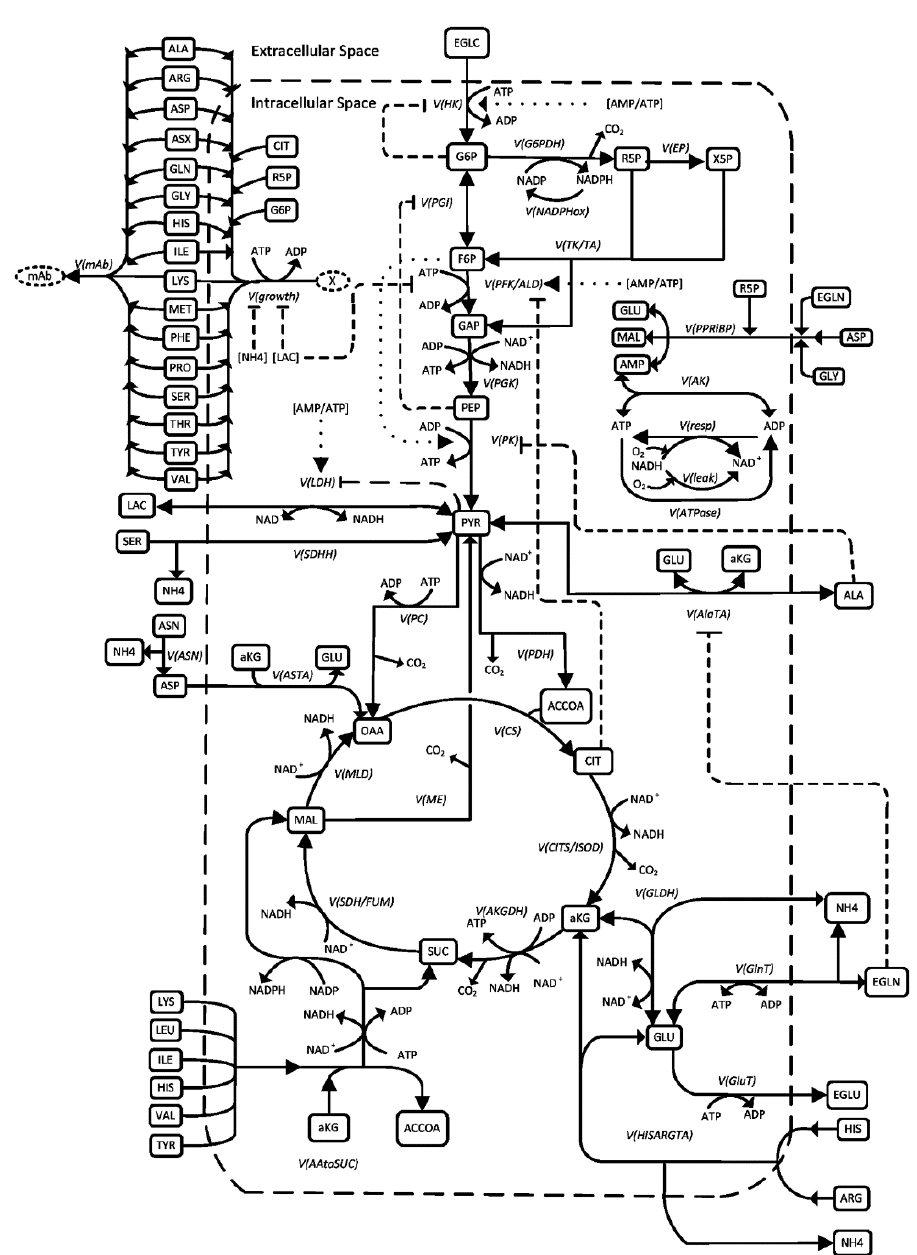
Figure 4. The metabolic network is described by the model. Biochemical reactions are depicted by solid lines, inhibition mechanisms by dashed lines and activation mechanisms by dotted lines. Figure taken from [45].